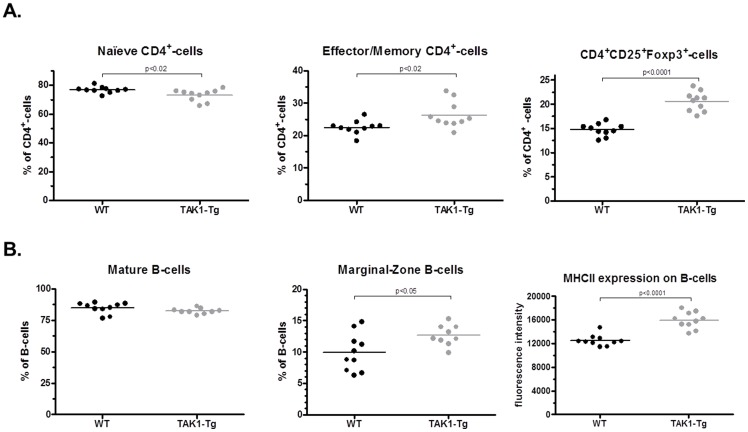
TAK1 knockdown shows more activated T- and B-cells in the spleen and bone marrow.Wildtype (WT) and TAK1 shRNA transgenic mice (TAK1-Tg) were treated with 0.2 mg/ml doxycycline in the drinking water for five weeks. Mice (n = 10 in each group) were sacrificed and spleens and bone marrow were harvested. Characterization of T- and B-cells was performed by flow cytometry. The percentage of naive T-cells (CD4+CD62L+CD44int), effector/memory T-cells (CD4+CD62L−CD44+) and regulatory T-cells (CD4+CD25+Foxp3+) are presented as % of total CD4+ cells in panel A. The percentage of mature B-cells (B220+AA4.1−CD23+IgMlow), Marginal zone B-cells (B220+AA4.1−CD23−IgMhigh) and MHCII-expression on B220+ cells (in fluorescence intensity) are depicted in panel B. Statistical significance was determined using the Mann-Whitney test (p<0.05). Data are representative of at least two independent experiments.